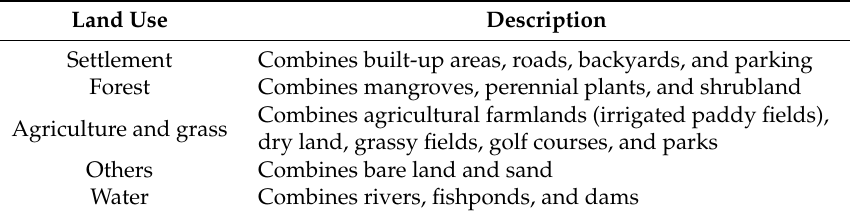
Table 1. Definition of land use types for the current